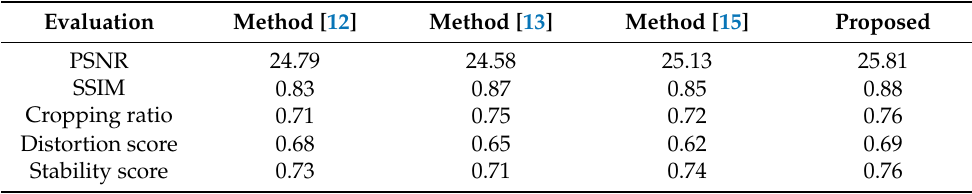
Figure 10. Video thumbnail: ( a ) video 1; ( b ) video 2; ( c ) video 3. Table 1. Video stabilization effect comparison of video 1.